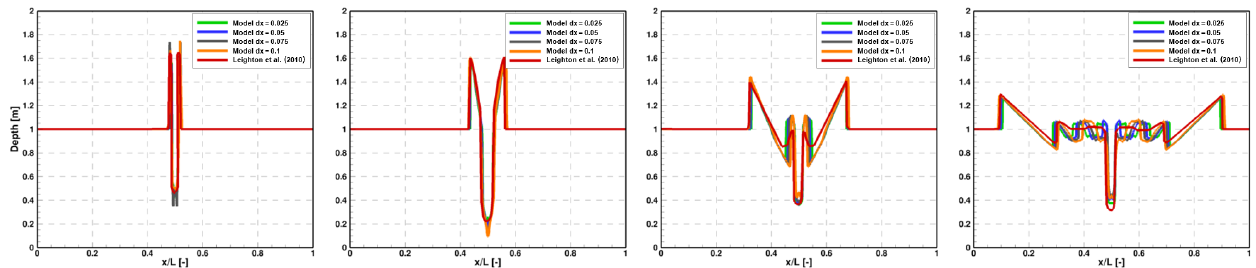
Figure B5. Density-driven dam break. Case ρ 2 = 10kgm − 3 : comparison of the flow depth at ˆ t = 1, 4, 12, and 30s from the beginning of the simulation.